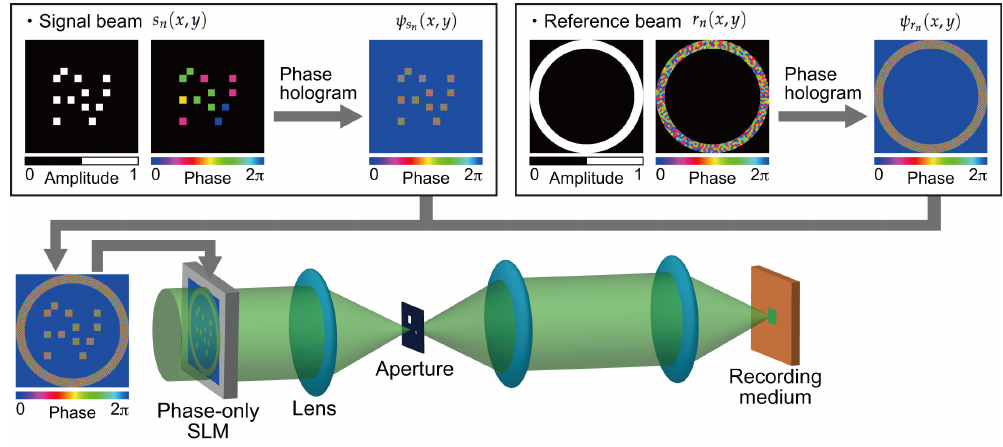
Figure 1. Recording process in a holographic storage system using digital holographic